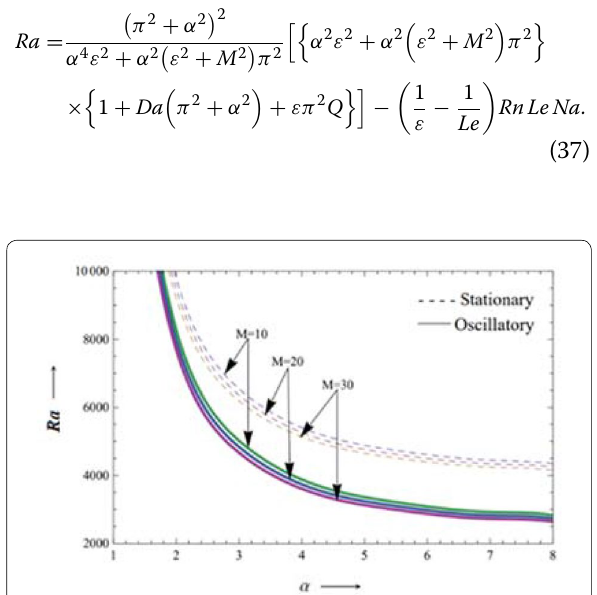
Fig. 7 Effect of Hall current parameter on Rayleigh number